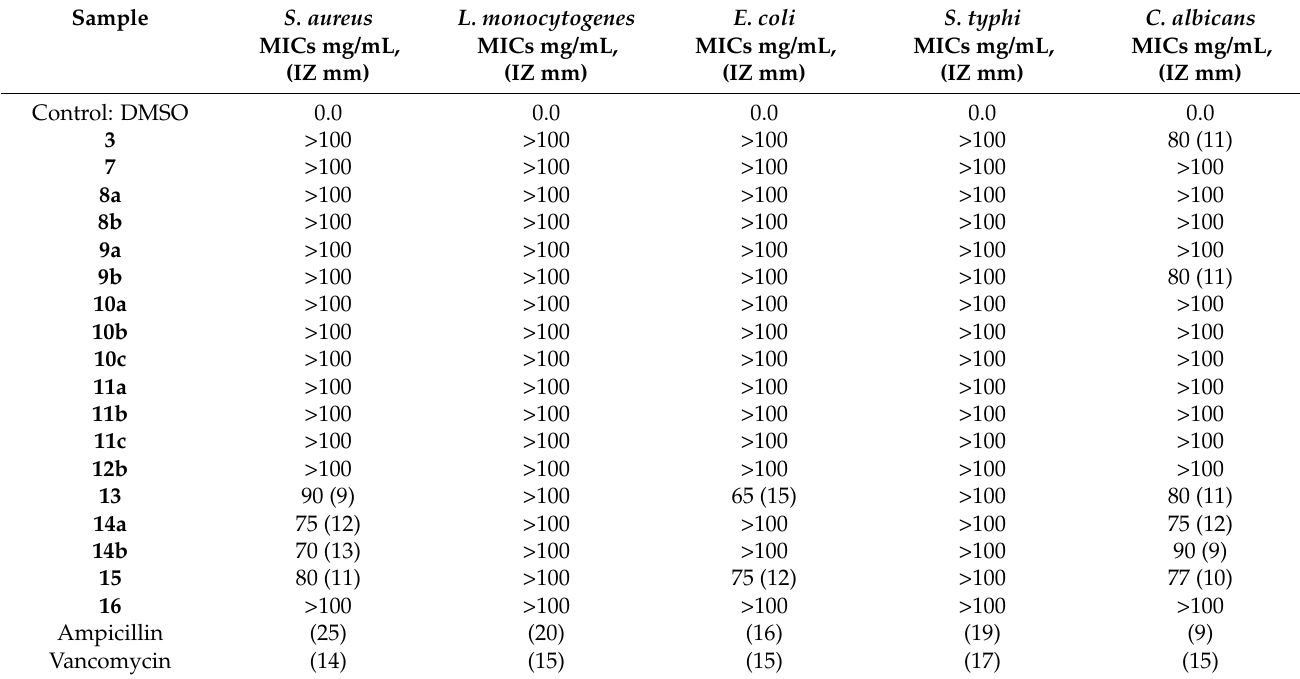
Table 1. The antimicrobial activity as the inhibition zone value (IZ mm) and minimum inhibitory concentration (MICs mg/mL) for the synthesized compounds against Staphylococcus aurous , Listeria monocytogenes , Escherichia coli , Salmonella typhi , and Candida albicans